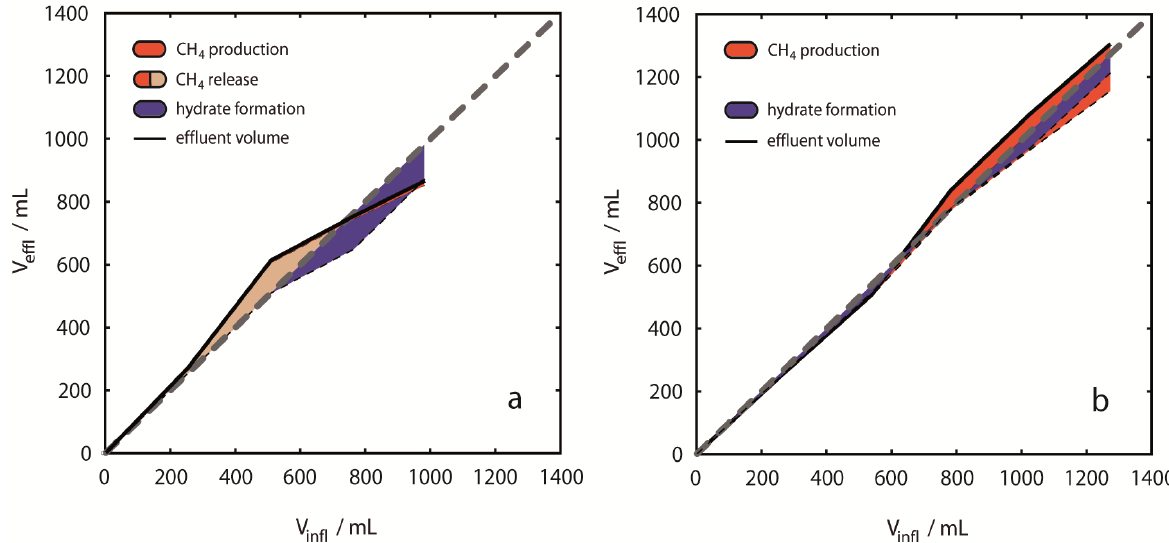
Figure 7. Fluid volume balancing and evaluation of phase distribution. Deviations from even volume balances [grey dashed lines in ( a ) – ( d )] are shown as colored areas related to . The figure emphasizes the difference between CH the cumulative volume of injected CO 2 production (red areas) and CH release (pink areas plus red areas). The volume based 4 hydrate formation potential was derived from negative volume differences (blue